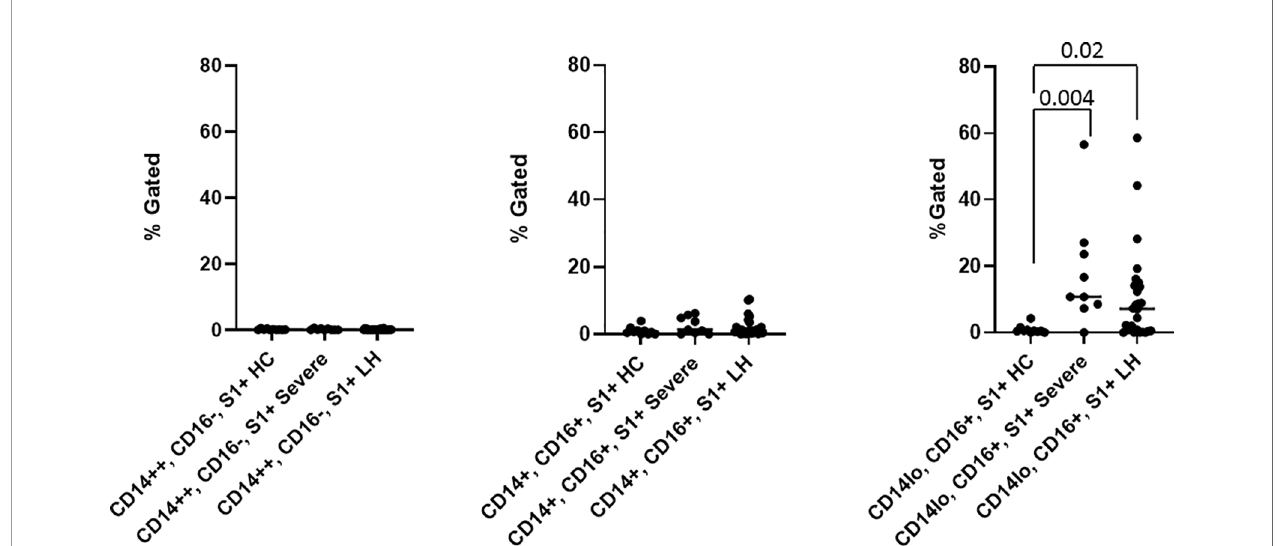
FIGURE 3 | Quanti fi cation of SARS-CoV-2 S1 protein in monocyte subsets isolated from healthy 63 controls (HC), severe COVID-19 (severe), and PASC patients (LH). SARS-CoV-2 S1 protein was expressed in non-classical monocytes in both severe and PASC individuals. Values (median value-horizontal line) for each category were based on the parental gating in Supplementary Figure 1 . Statistical analysis was performed using the Kluskal-Wallis test. P values <0.05 are considered signi fi